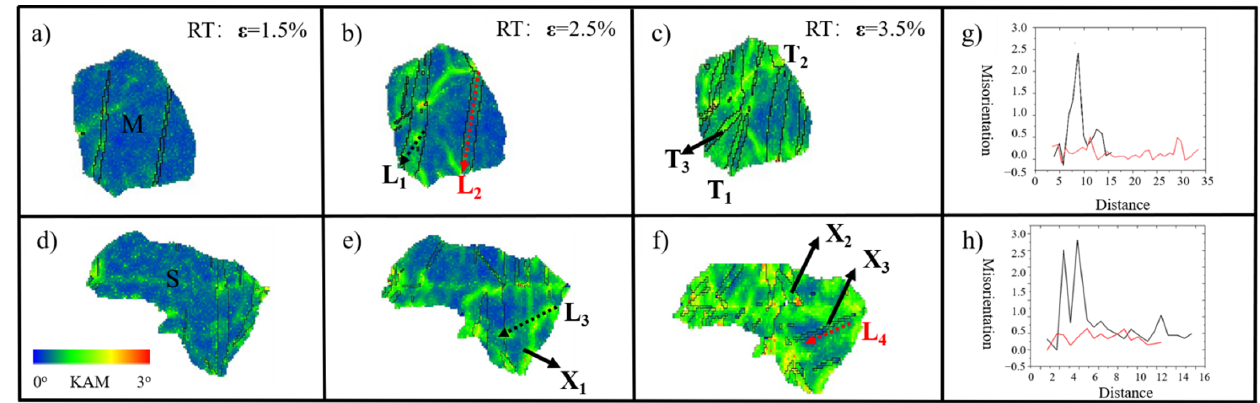
Figure 8. ( a – f ) KAM maps with selected grains at different strain levels: ( a ) RD 1.5%; ( b ) RD 2.5%;( c ) RD 3.5%, ( g – h ) point-to-point figures corresponding to L1–L4, respectively.